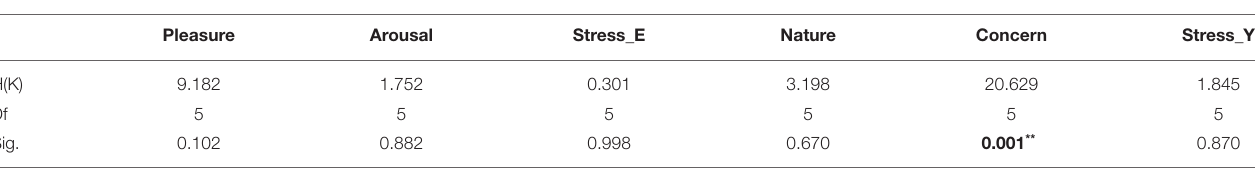
TABLE 3 | Kruskal–Wallis Test (grouping variable: photo type).